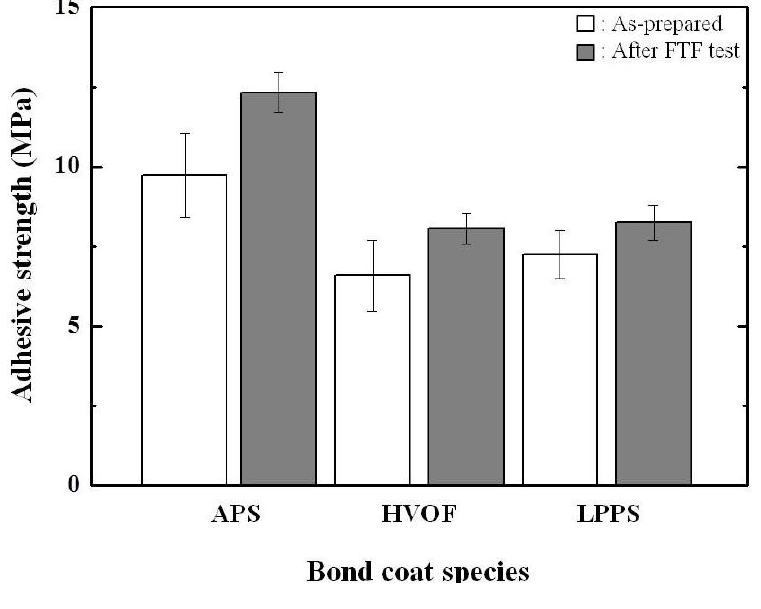
Figure 12. Adhesive strength values of TBCs before and after the